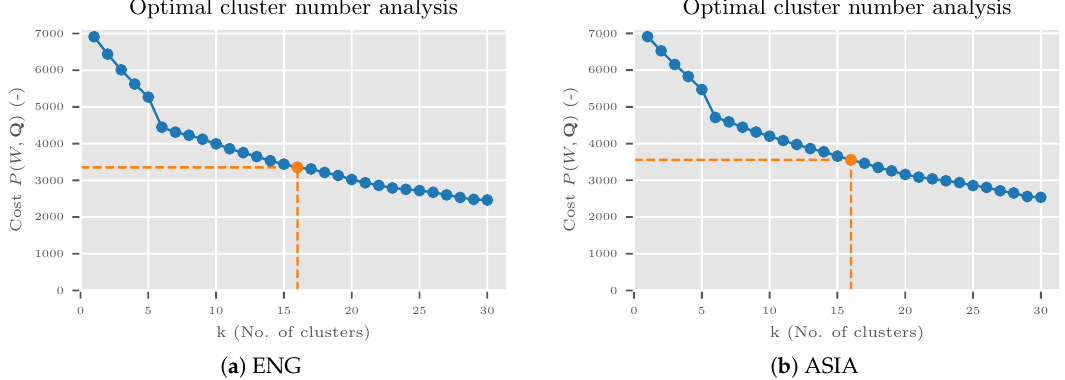
Figure 13. Optimal cluster number analysis for the VireoFood-172 experiment. The analysis was done by the k-Modes algorithm for ENG population ( a ) and ASIA population ( b ). Sixteen clusters were selected (orange